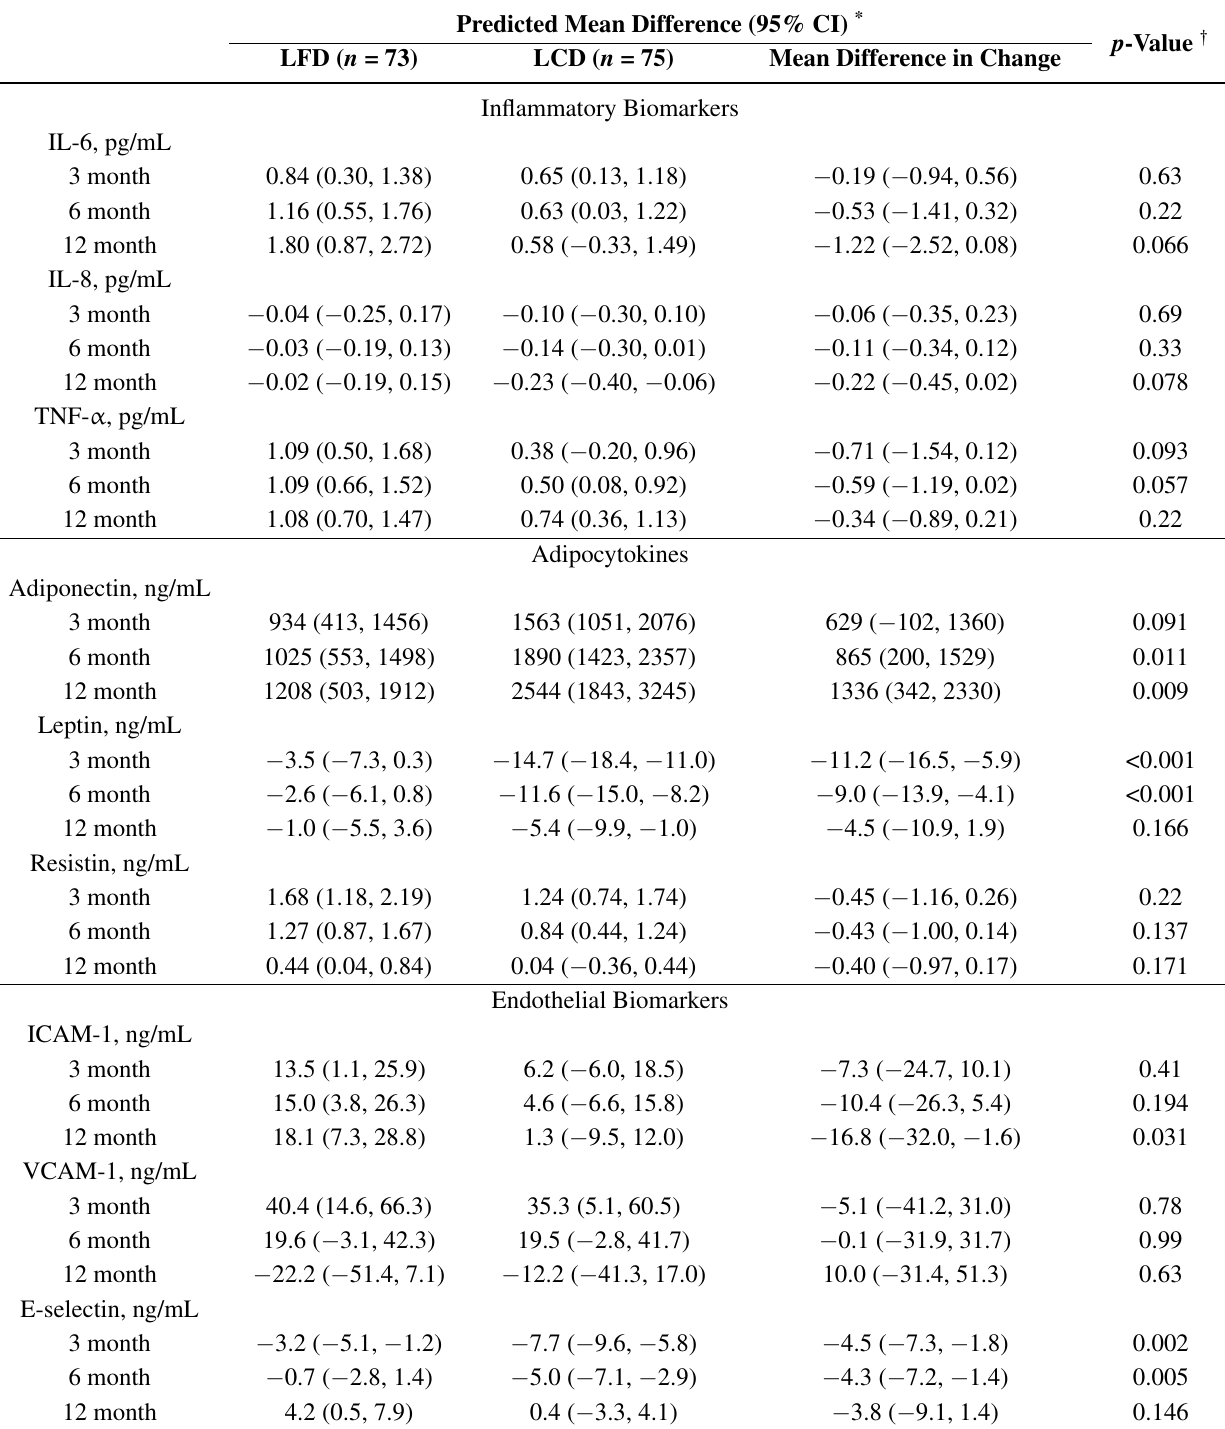
Table 3. Predicted mean difference in changes in novel cardiovascular biomarkers from baseline, by assigned diet